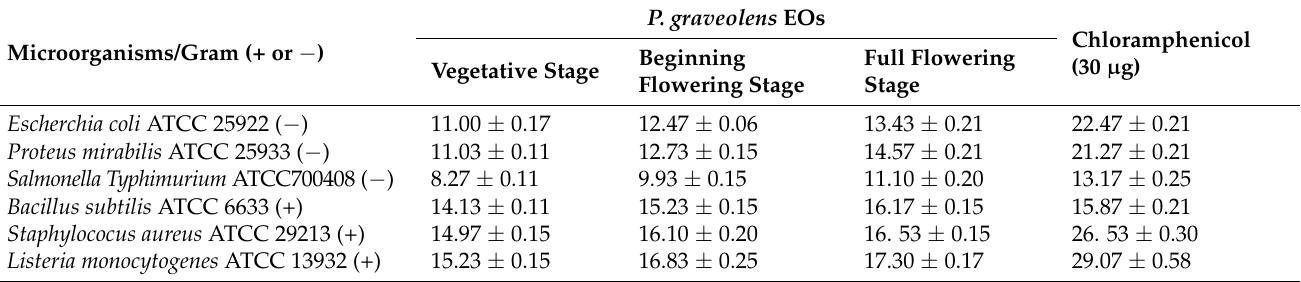
Table 2. The inhibitory diameters (mm) of PGEO at three developmental stages against bacterial strains.